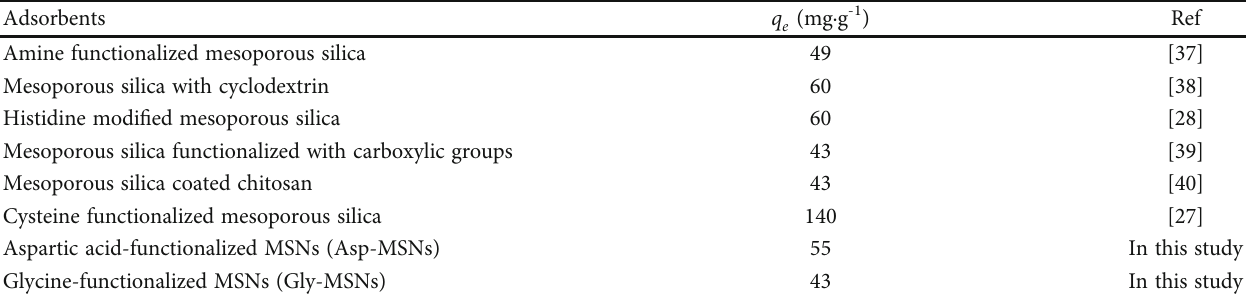
Table 2: The maximum adsorption capacities of di ff erent adsorbents for removing MB from aqueous solution, reported in the past